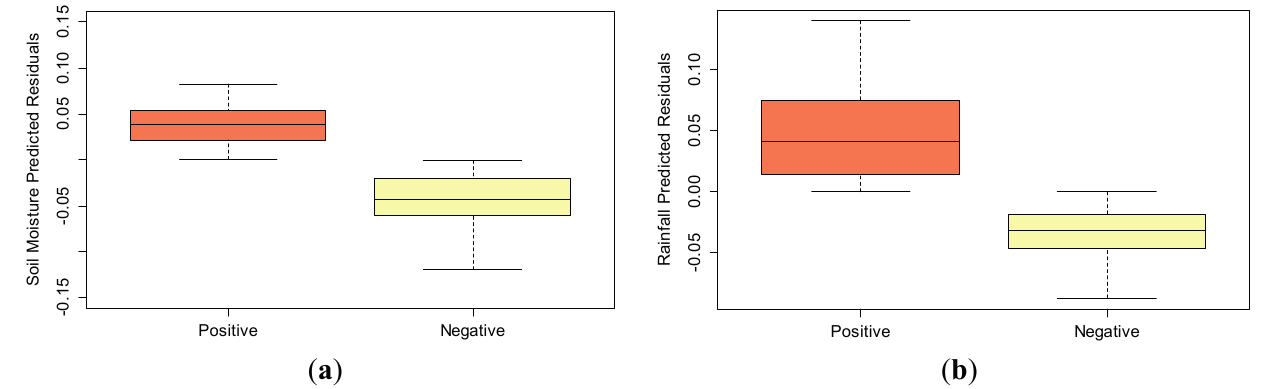
Figure 5. Trends of NDVI residuals that have been adjusted for ( a ) soil moisture and ( b ) rainfall with RESTREND. Note difference of